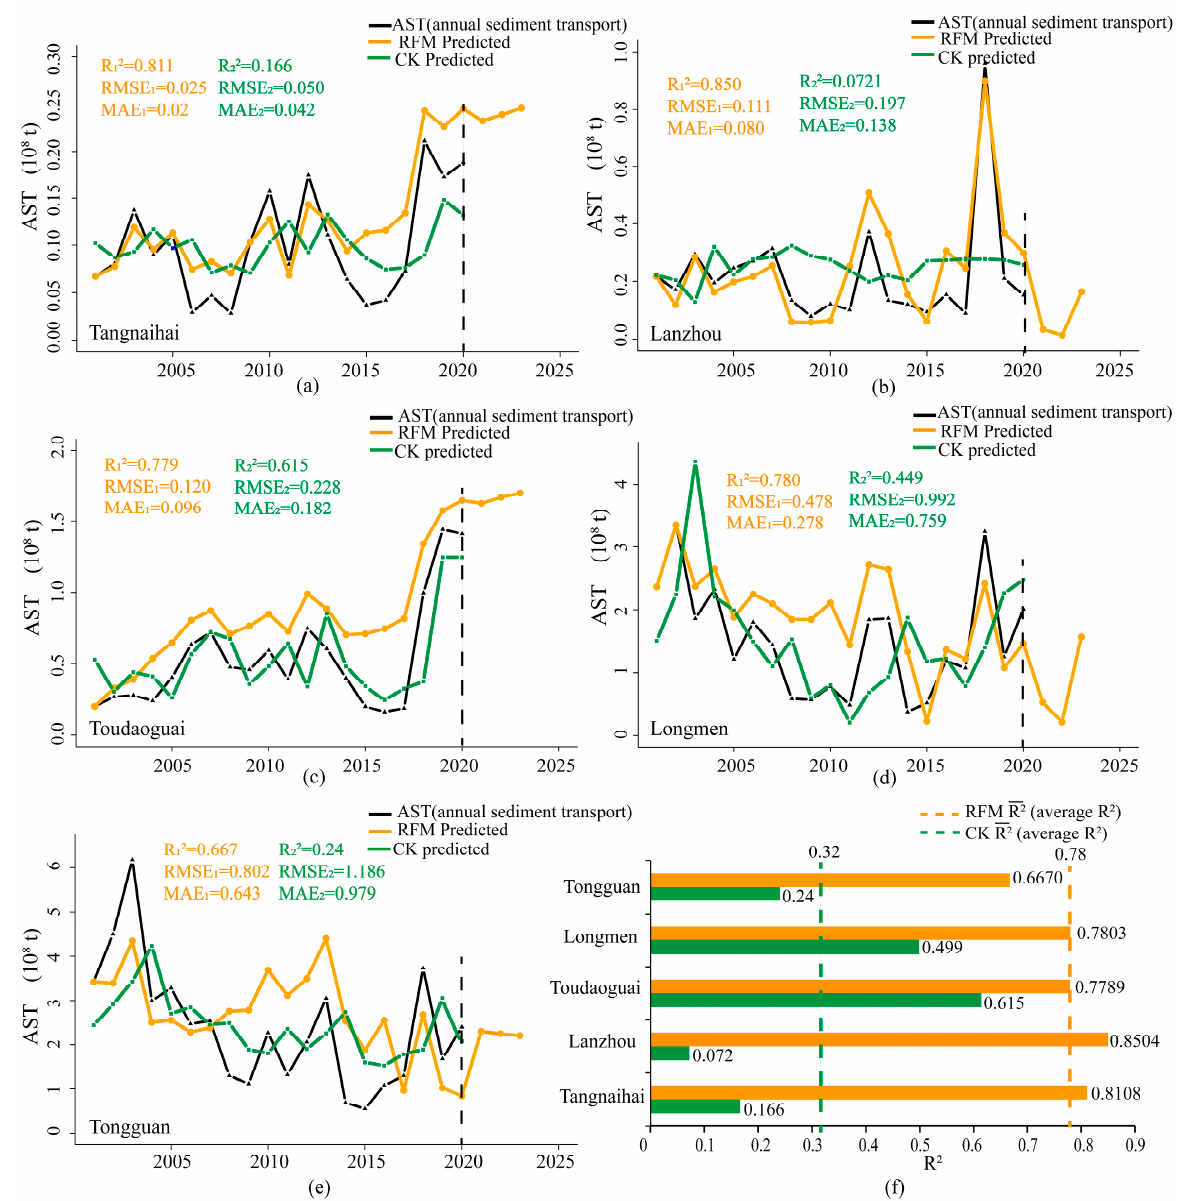
Figure 8. ( a – e ) The prediction of AST at the five gauge stations in the UMRYR using the RFM and ARIMA models, and a comparison with the measured AST data. The left side of the black dotted line represents the forecast for the known years (2001 to 2020), while the right side represents the forecast for the unknown years (2021 to 2023). ( f ) The prediction accuracy comparison for the five gauge stations using the RFM and ARIMA models. Table 6. AST data for the five gauge stations for the next 3 years, predicted by the RFM. The abbreviation AST denotes the annual sediment transport and RFM denotes the random forest